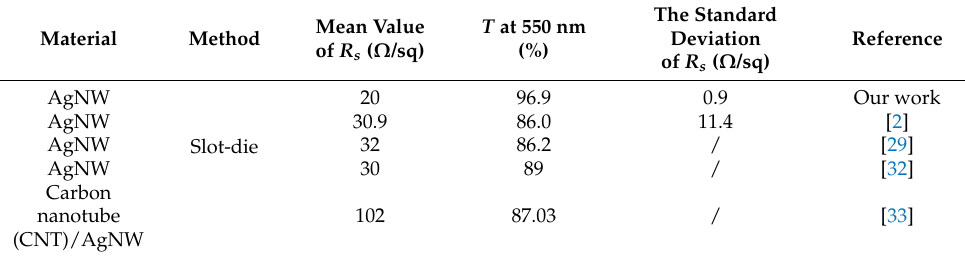
Figure 6. ( a ) The photograph of AgNW TCF (15 cm × 15 cm) connected in series with a power sup- ply, LED, switch, and wires. ( b ) Variations in resistance of the optimized AgNW TCF during re- peated bending test. ( c ) SEM morphology of the optimized AgNW TCF ( d ) AFM image of the opti- mized AgNW TCF.